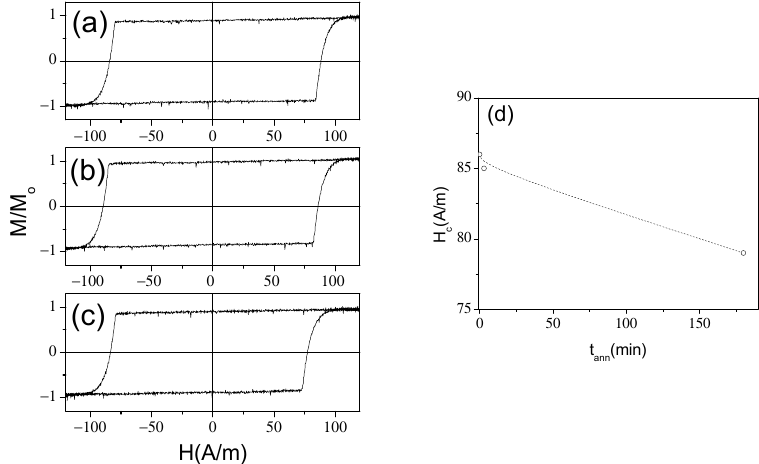
Figure 8. Hysteresis loops of as-prepared ( a ), and annealed at T ann = 400 °C for 3 min ( b ) and 180 min ( c ) Fe 75 B 9 Si 12 C 4 microwires and dependence of coercivity on annealing time ( d ).